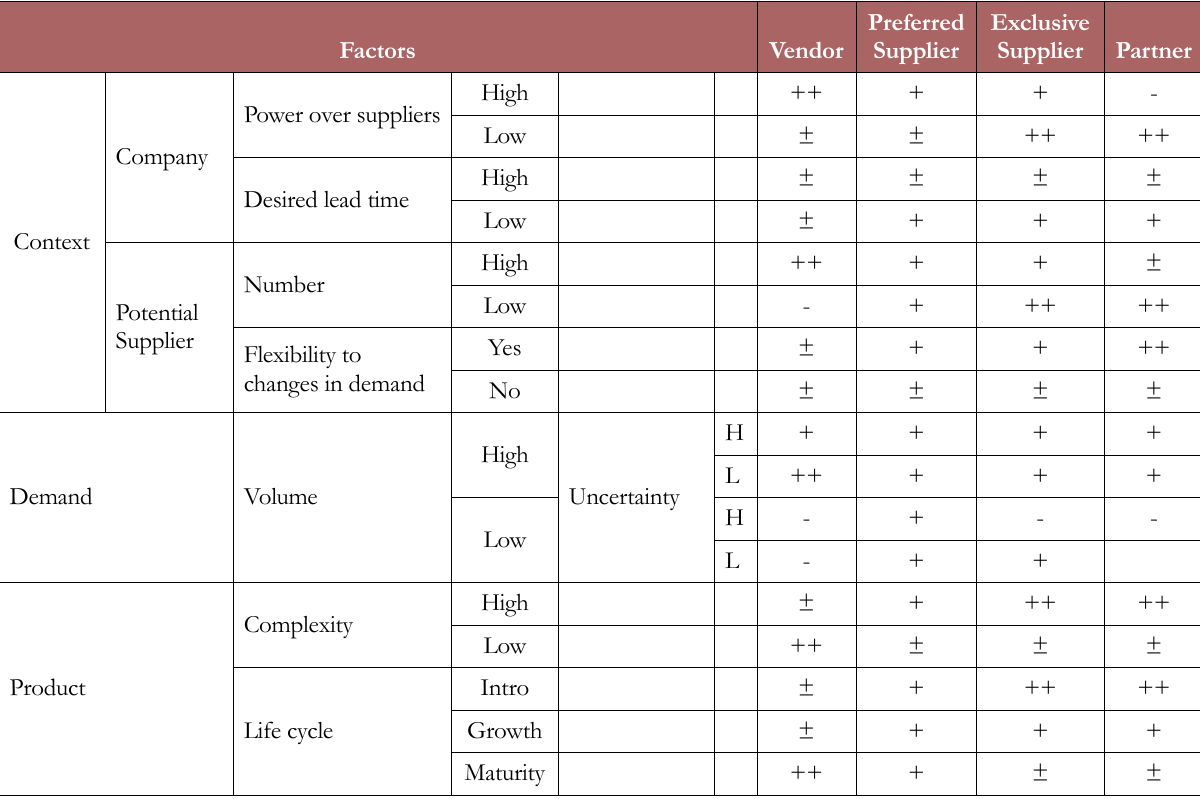
Table 4. Evaluation of the relevant factors in selecting the buyer-supplier